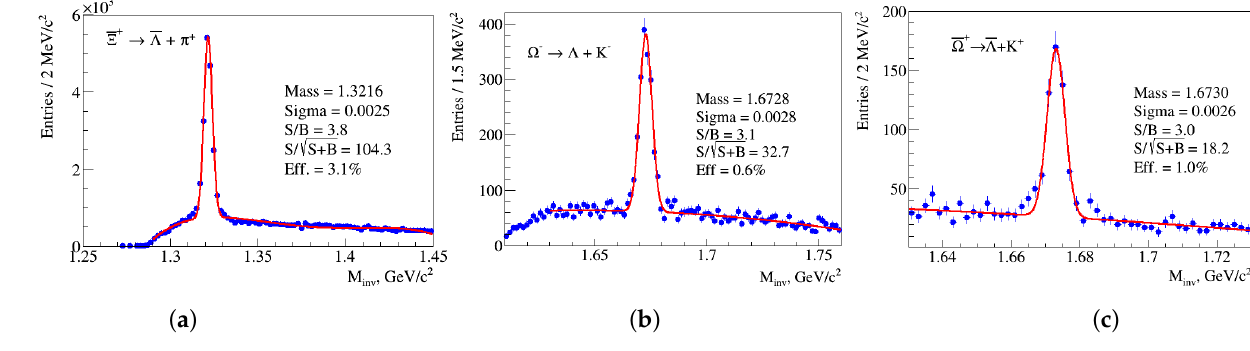
+ → Λ + π + , ( b ) Ω − → Λ + K − , √ s NN = 11 GeV have